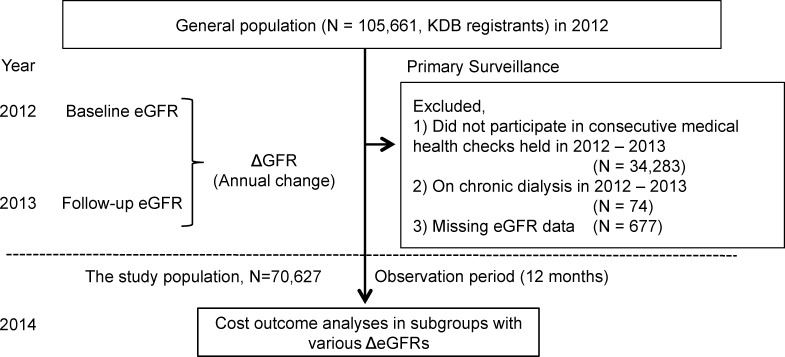
Study design.Strategy for recruitment of the study population, follow-up, and outcome analyses. Abbreviations: KDB, Kokuho database; eGFR, estimated glomerular filtration rate; ΔGFR, annual change in eGFR.